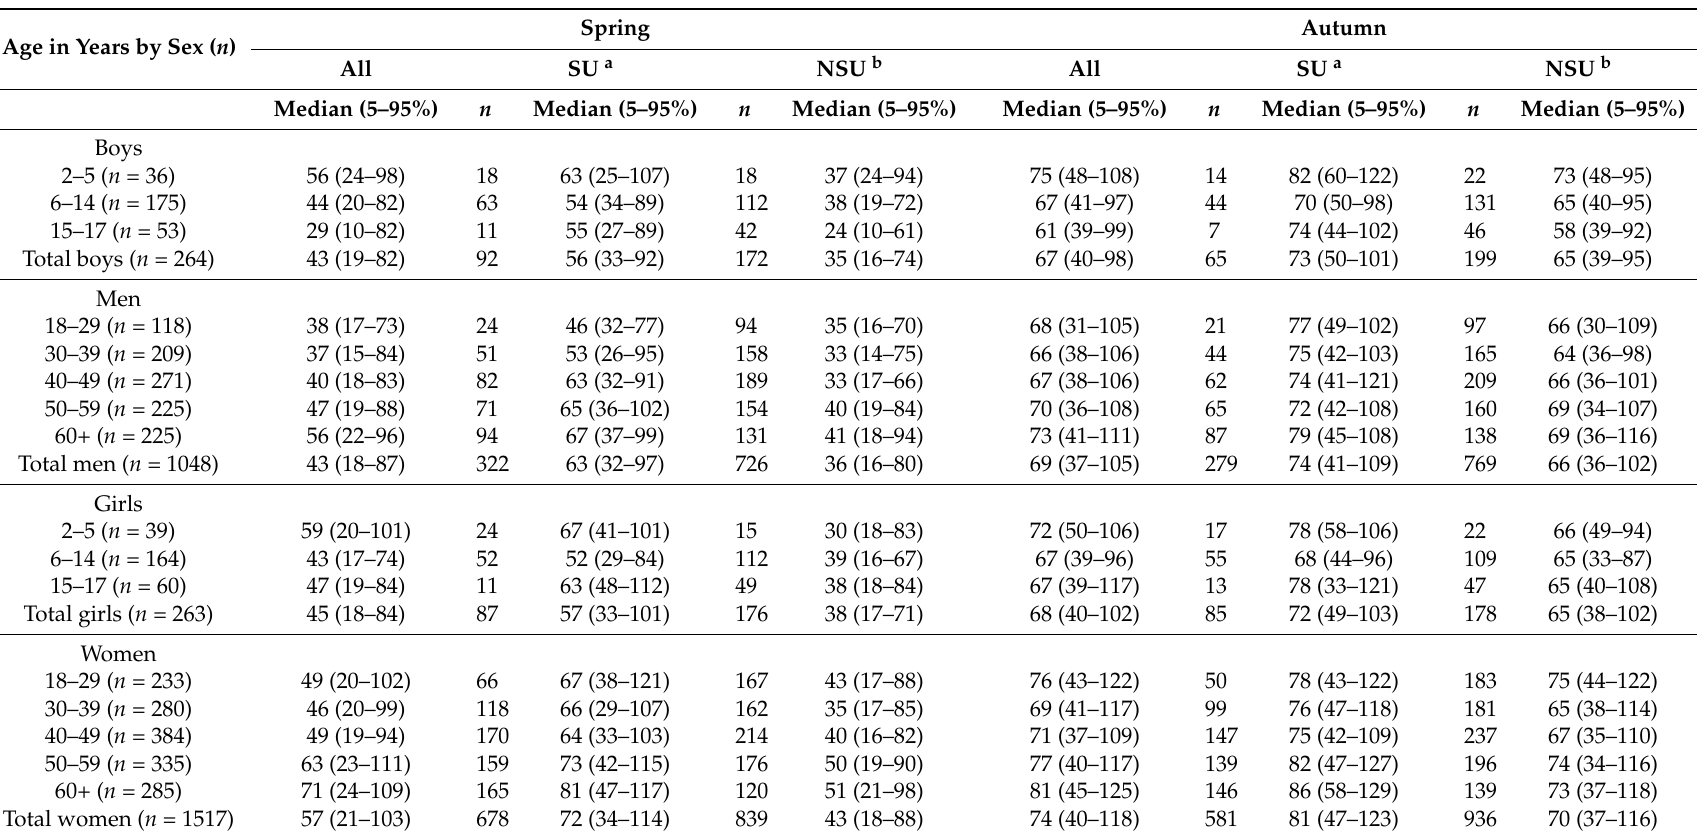
Table 1. Median serum 25-hydroxyvitamin D (25(OH)D) concentrations (nmol/L) stratified by season, sex, and supplement use among children (2–17 years) and adults (18–69